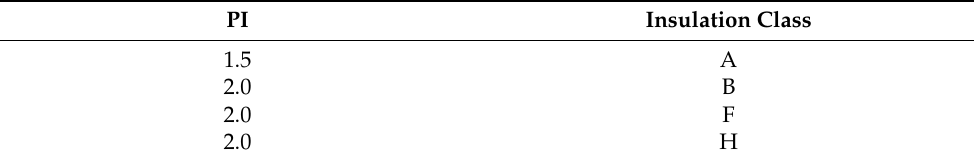
Table 5. Insulation classes and the minimum PI value.